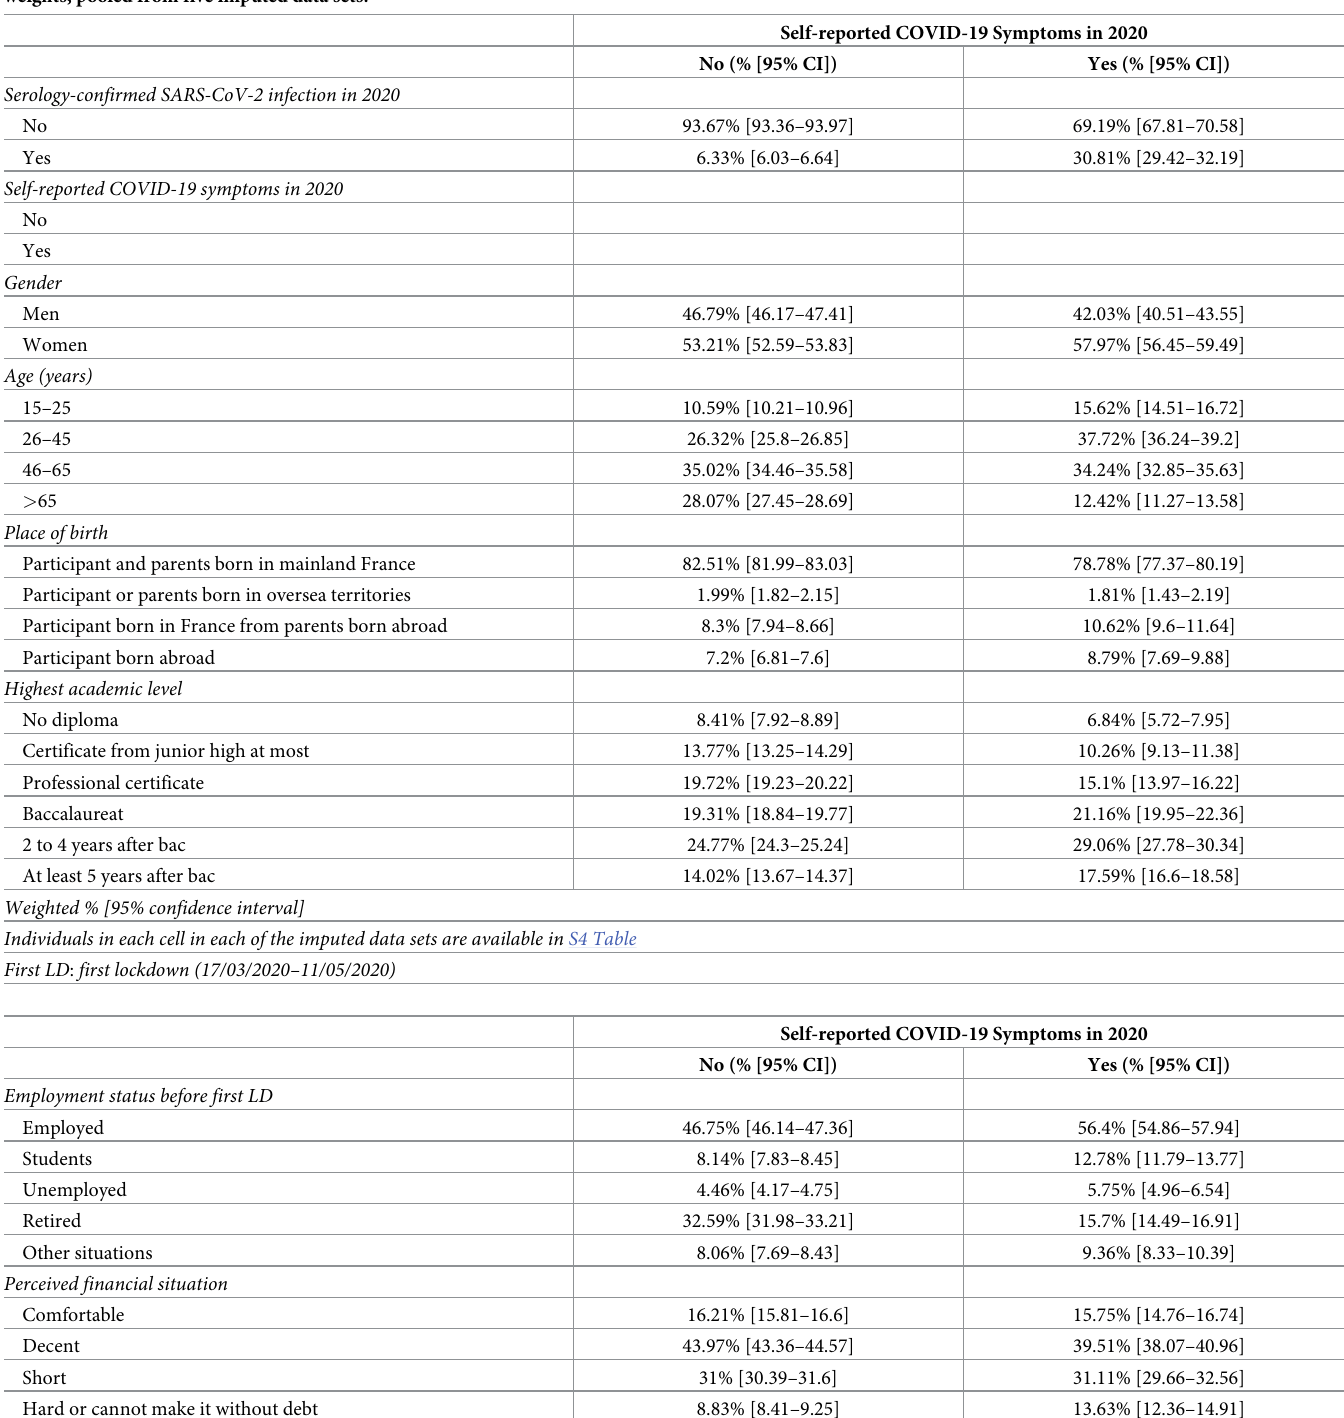
Table 2. Prevalence of serology-confirmed SARS-CoV-2 infection and covariates according to self-reported COVID-19-like symptoms in 2020, weighted by study weights, pooled from five imputed data